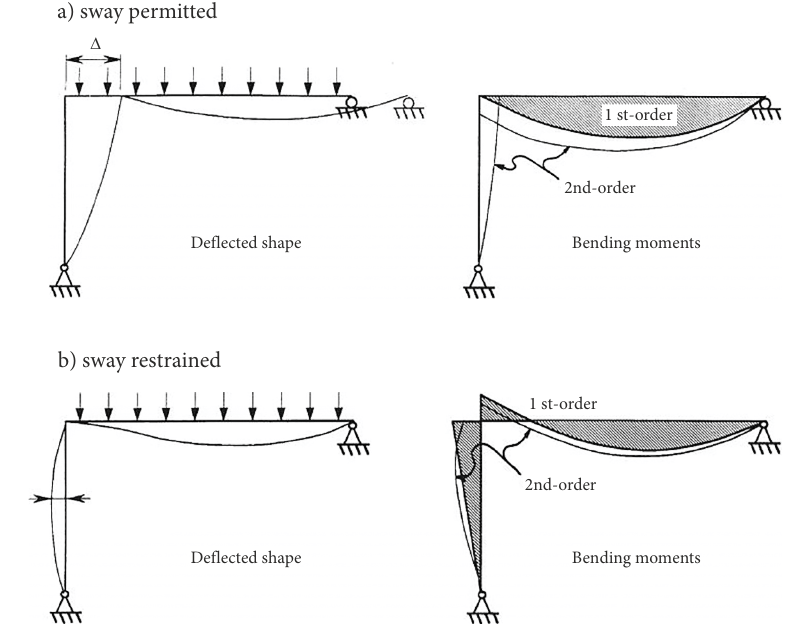
Figure 1. Second-order effects P- Δ and P-